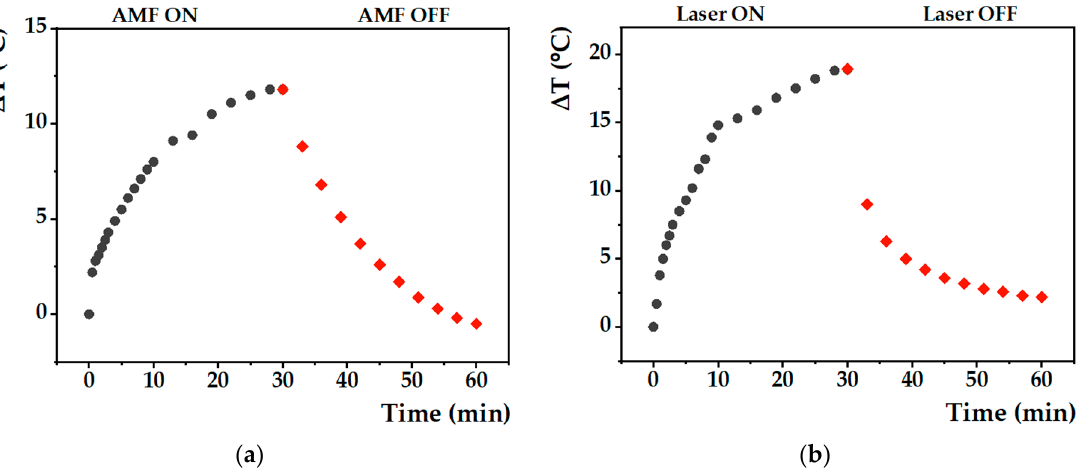
Figure 5. Heating profile (gray: heating; red: cooling) of the aqueous solutions of calcined Mg 0.75 Ca 0.25 Fe 2 O 4 nanoparticles under exposure to: ( a ) AMF with 11 mT amplitude and frequency of 155 kHz; ( b ) laser light source with 808 nm wavelength and 1 W/cm 2 power density.